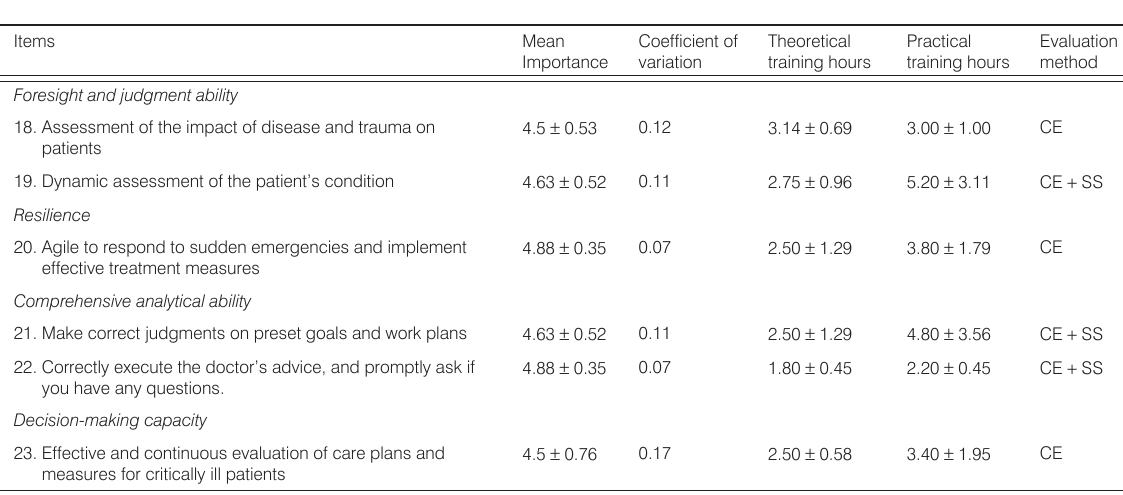
Table 3. Core competencies of backup nurses for critical thinking